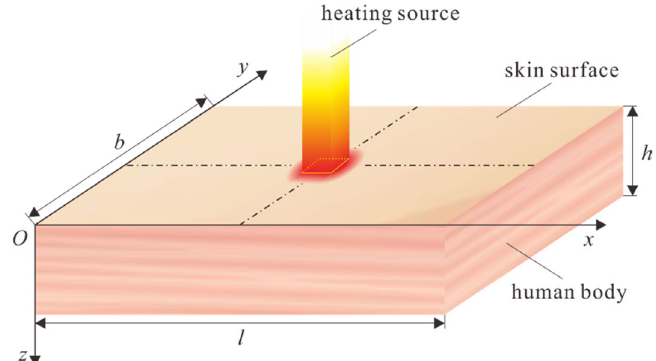
Figure 1. Illustration of the 3D skin